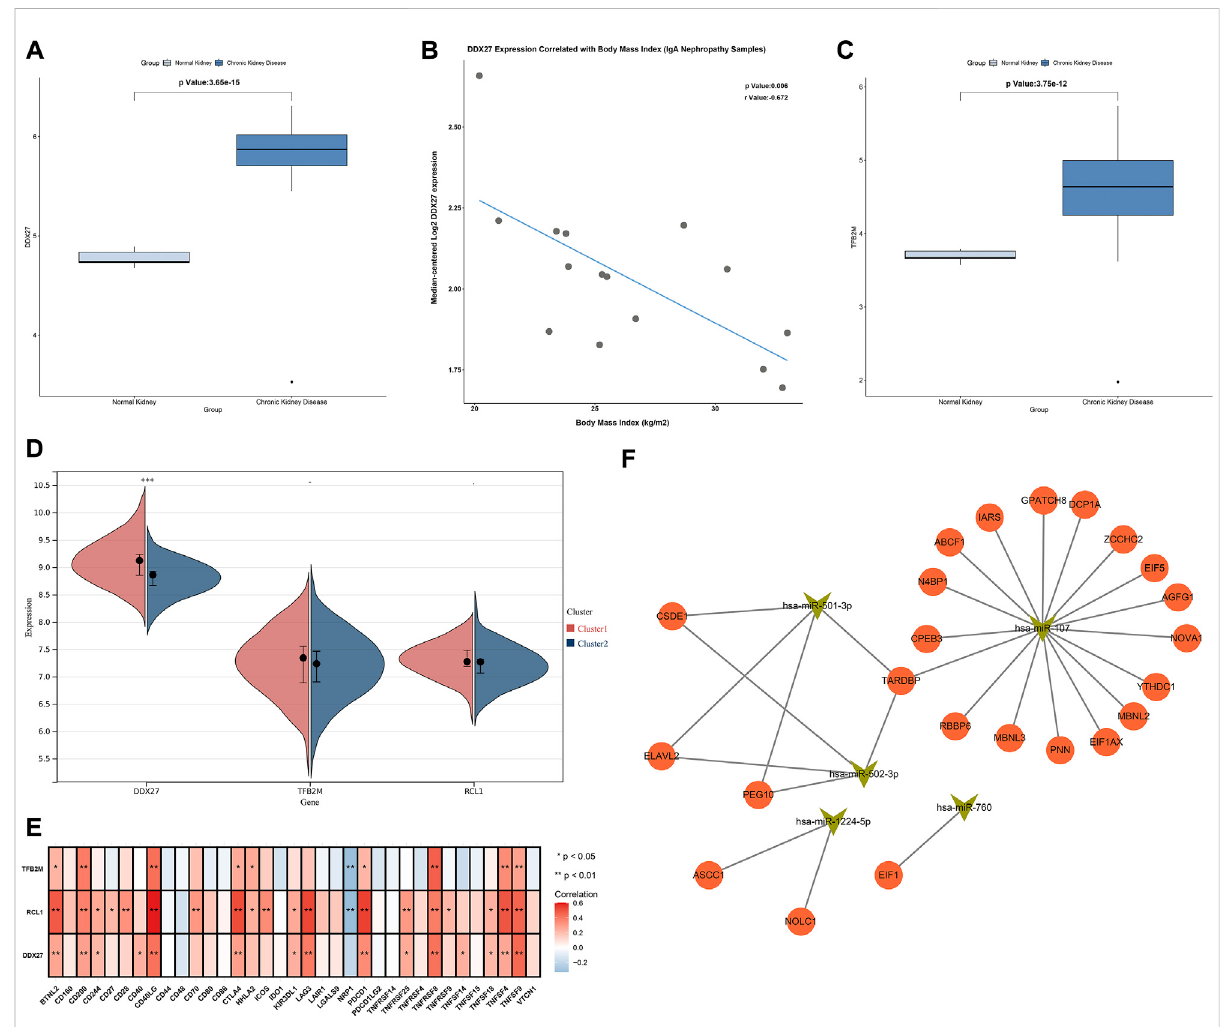
FIGURE 8 Association of characteristic RBPs with clinical features, hub RBPs-based subtypes, immune cell in fi ltrations and upstream miRNAs. (A) Expression of DDX27 in normal and chronic kidney disease in the Nephroseq database. (B) Correlation between DDX27 expression and body mass index of IgA nephropathy samples in the Nephroseq database. (C) Expression of TFB2M in normal and chronic kidney disease in the Nephroseq database. (D) Expression of characteristic RBPs in two subtypes. (E) Heatmap of the associations between characteristic RBPs and immune cell in fi ltrations in IgA nephropathy. (F) The network of characteristic RBPs and upstream miRNAs. * p < 0.05; ** p <